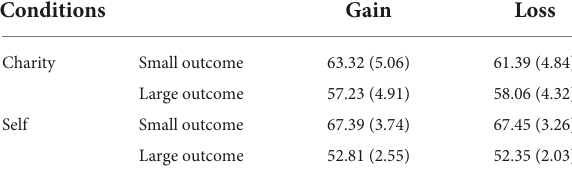
TABLE 1 The mean trials and discarded trials of all the experimental